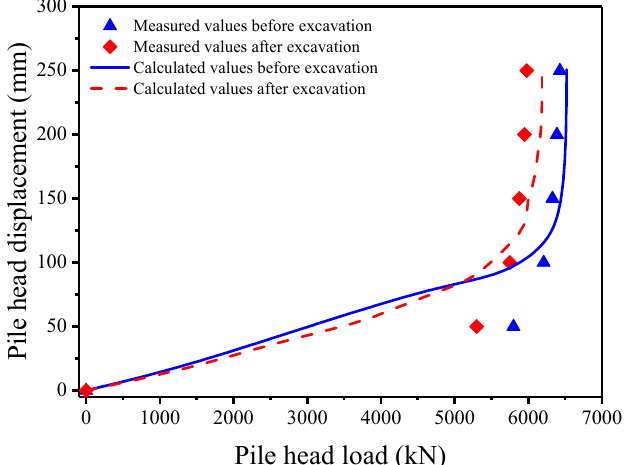
Figure 9. Comparison between the calculated and centrifuge test results of an uplift pile before and after excavation.